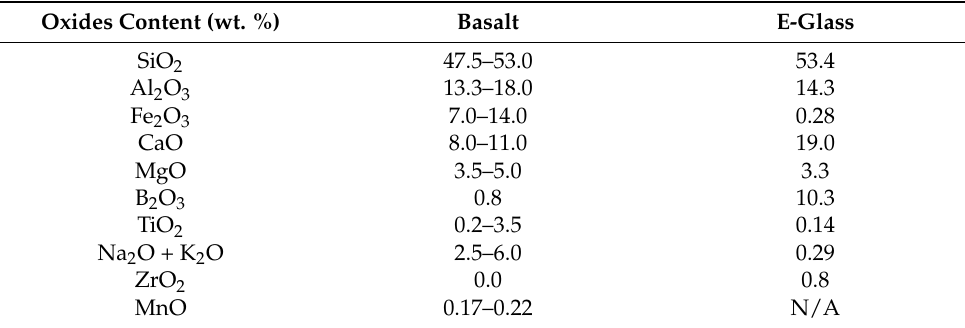
Table 2. Chemical composition of basalt and E-glass fibres [9,43,59]. Oxides Content (wt. %) Basalt E-Glass SiO 2 47.5–53.0